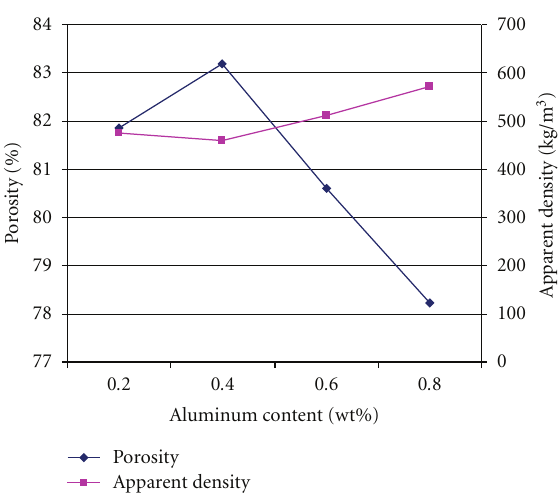
Figure 1: Apparent density and porosity of ACCC as a function of aluminum powder content.